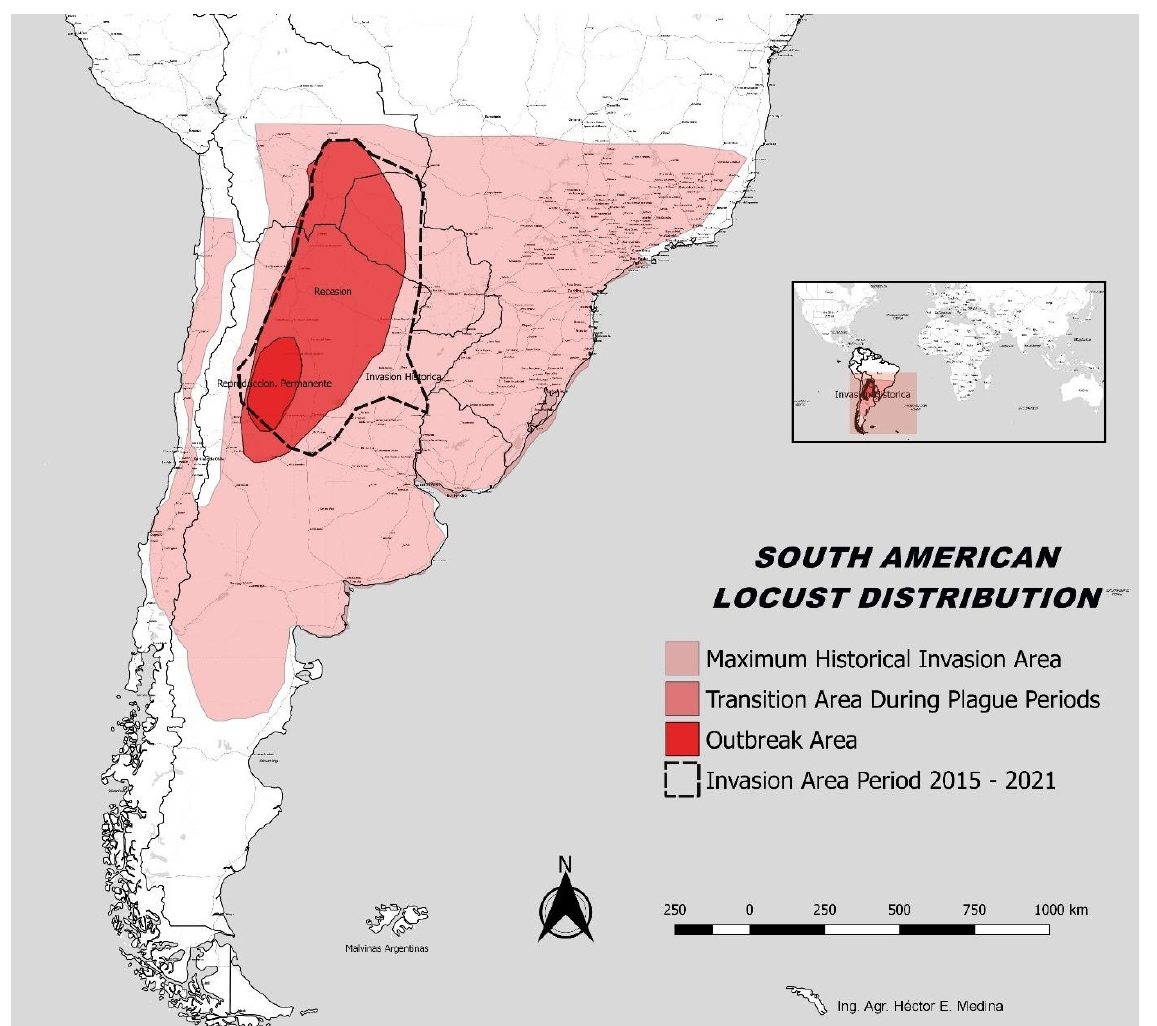
Figure 2. South American locust distribution map. Adapted from de Wysiecki and Lange, 2005.